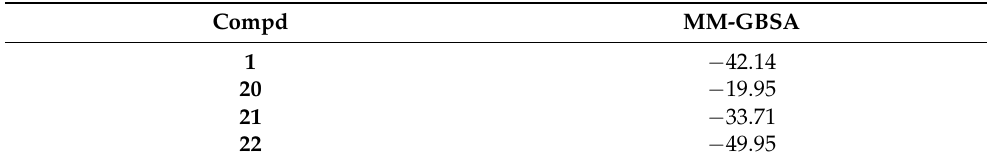
Table 6. Calculated MM-GBSA binding energies (kcal/mol) for compounds 1 and 20–22 against 2OM3 over MD